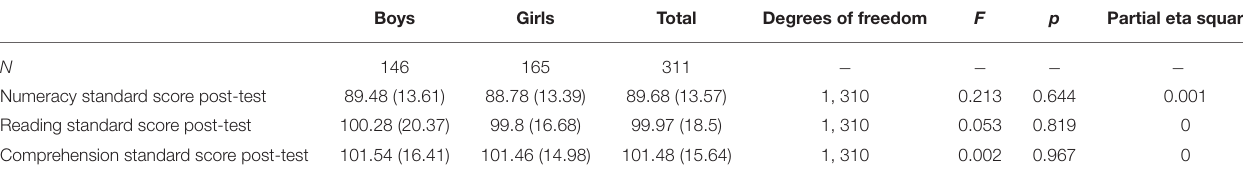
TABLE 5 | Post-test scores of boys and girls and results of ANOVAs comparing genders. Boys Girls Total Degrees of